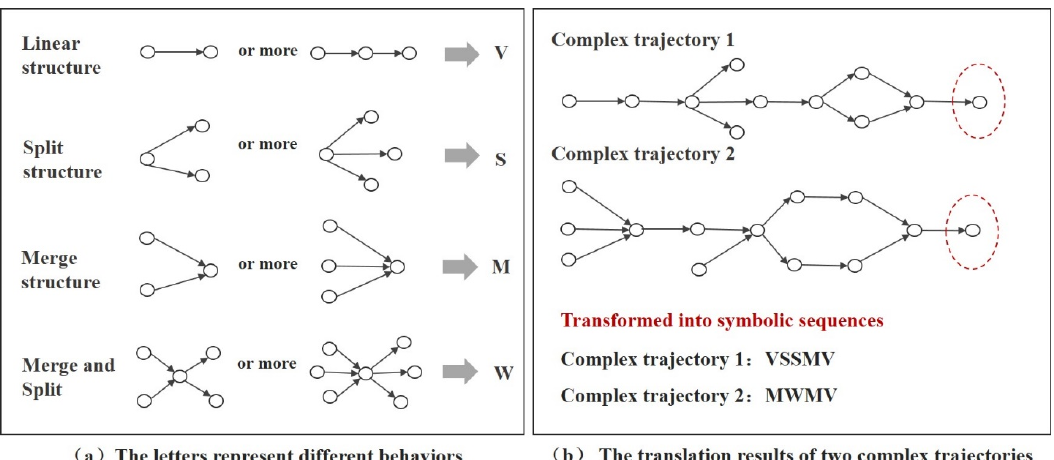
Figure 3. The letters represent different behaviors of an eddy ( a ) and the translation results (sequence of symbols) of two complex trajectories ( b ).